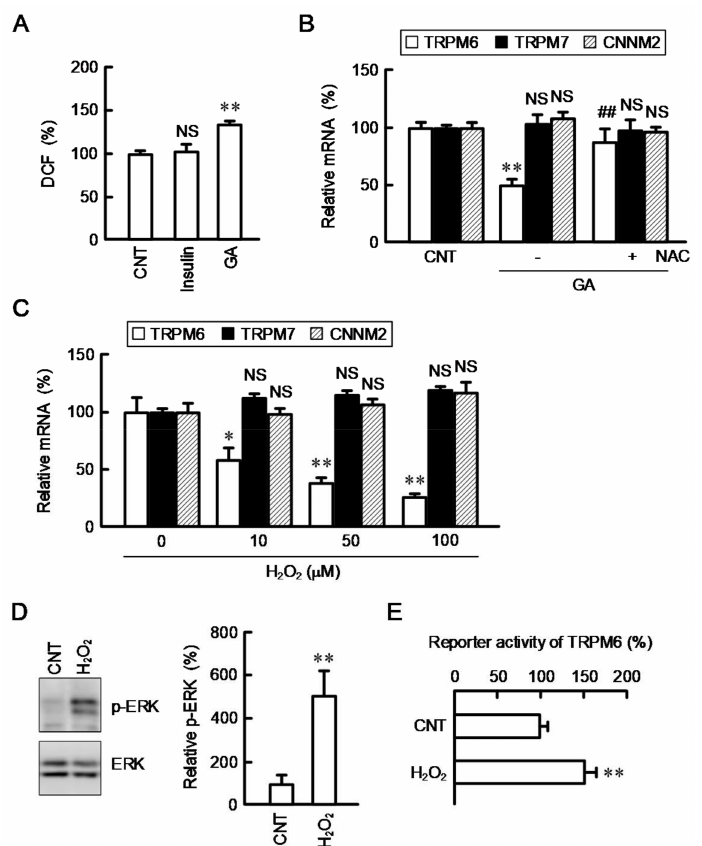
Figure 2. Effect of H 2 O 2 on mRNA expression and reporter activity of TRPM6. ( A ) NRK-52E cells were treated with vehicle (CNT), 10 nM insulin, and 500 µ g/mL GA for 1 h. The intracellular ROS contents were measured using DCF and represented as percentage of CNT. ( B ) Cells were treated in the presence or absence (CNT) of 500 µ g/mL GA and 2 mM NAC for 6 h. The mRNA levels of TRPM6, TRPM7, and CNNM2 were represented as percentage of CNT. ( C ) Cells were treated with H 2 O 2 for 6 h at the concentrations indicated. The mRNA levels of TRPM6, TRPM7, and CNNM2 were represented as percentage of 0 µ M. ( D ) Cells were treated with vehicle (CNT) and 50 µ M H 2 O 2 for 1 h. The expression levels of p-ERK and ERK were measured by Western blotting and represented as percentage of CNT. ( E ) The reporter vector of TRPM6 was transfected into the cells using HilyMax. The transfection efficiency was corrected for by the ratio of firefly luciferase activity to Renilla luciferase activity and represented as percentage of CNT. n = 3–5. ** p < 0.01, * p < 0.05 and NS p > 0.05 compared with CNT or 0 µ M. ## p < 0.01 compared with